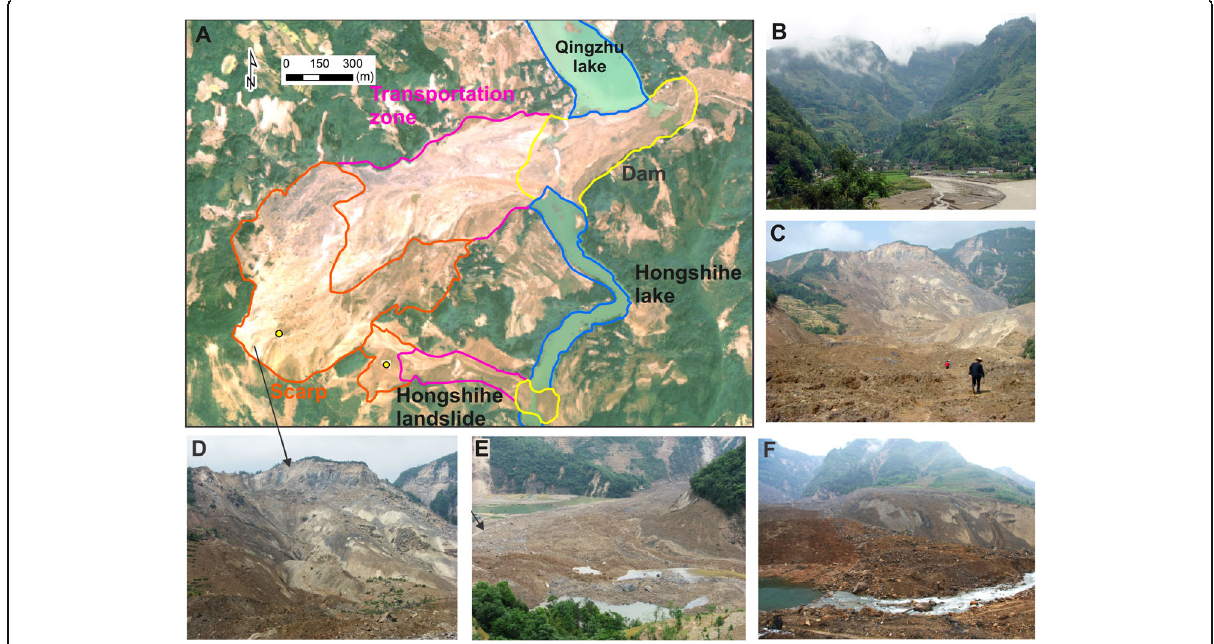
Fig. 7 Donghekou landslide. a Aerial photo of the Donghekou landslide; b and c Overview photo before and after the earthquake; d Head scarp; e The dam body and two barrier lakes; and f Artificial spillway